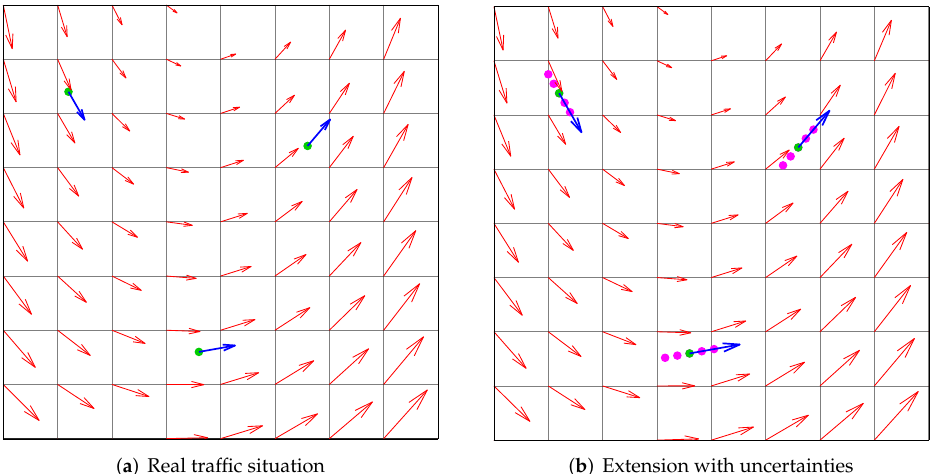
Figure 8. Traffic configuration with and without